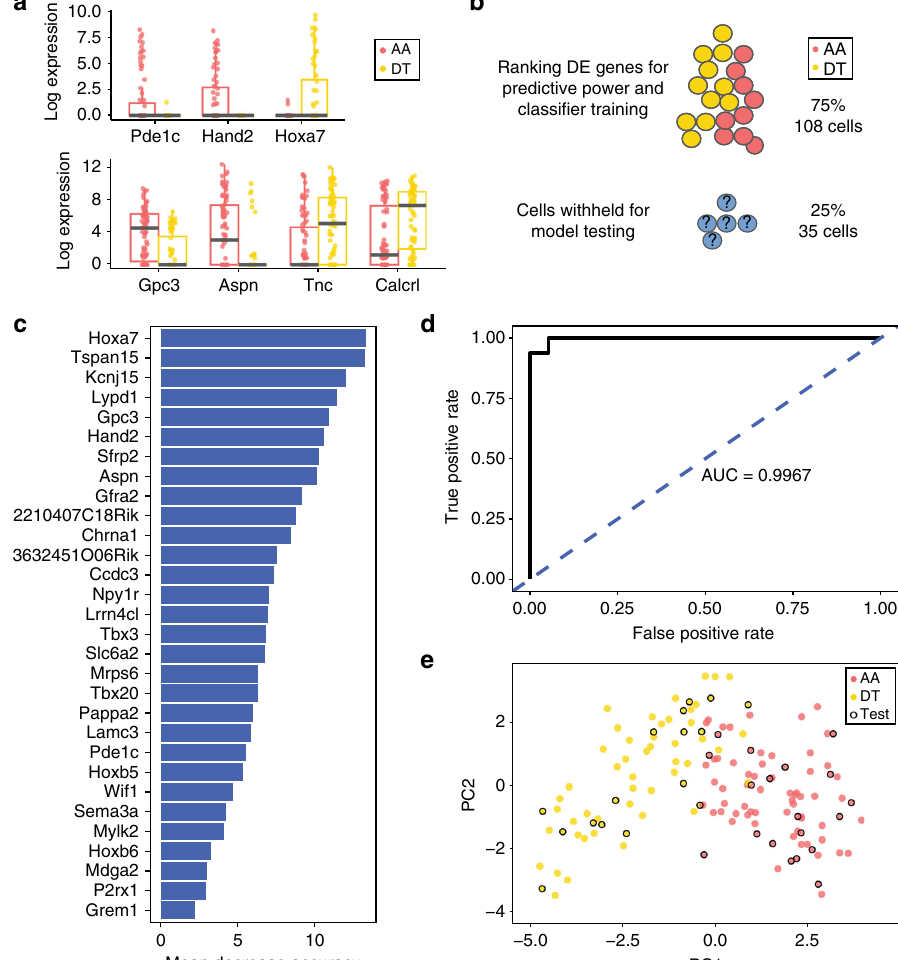
Fig. 3 Single-VSMC transcriptomes re fl ect regional identity. a Boxplots showing log 2 -transformed normalised expression of genes detected as differentially expressed between the aortic arch (AA, red) and descending thoracic aorta (DT, yellow) in bulk RNA-seq experiments across single VSMCs. Top panel: genes showing expression near-exclusively in cells from one tissue. Lower panel: genes that are expressed in different proportions of cells from the AA and DT. Median (centre line), fi rst and third quartiles (bounds of box) and 1.5 interquartile range (whiskers) and individual data points (dots) are indicated. b Schematic of the random forest analysis. The regional identity of 75% of the cells was used in classi fi er training and re fi nement. The remaining 25% of cells (35 cells) were tested with the model showing the best classi fi cation performance with the 75% subset. c The out-of-bag mean decrease in classi fi cation accuracy for the 30 genes used in the fi nal classi fi er. d ROC curve showing the performance of the classi fi er on the 25% subset of cells that were not used for model testing and re fi nement. e PCA plot based on the 30 genes used in the fi nal classi fi er, showing AA (red) and DT (yellow) cells. Cells in the 25% test subset are circled in